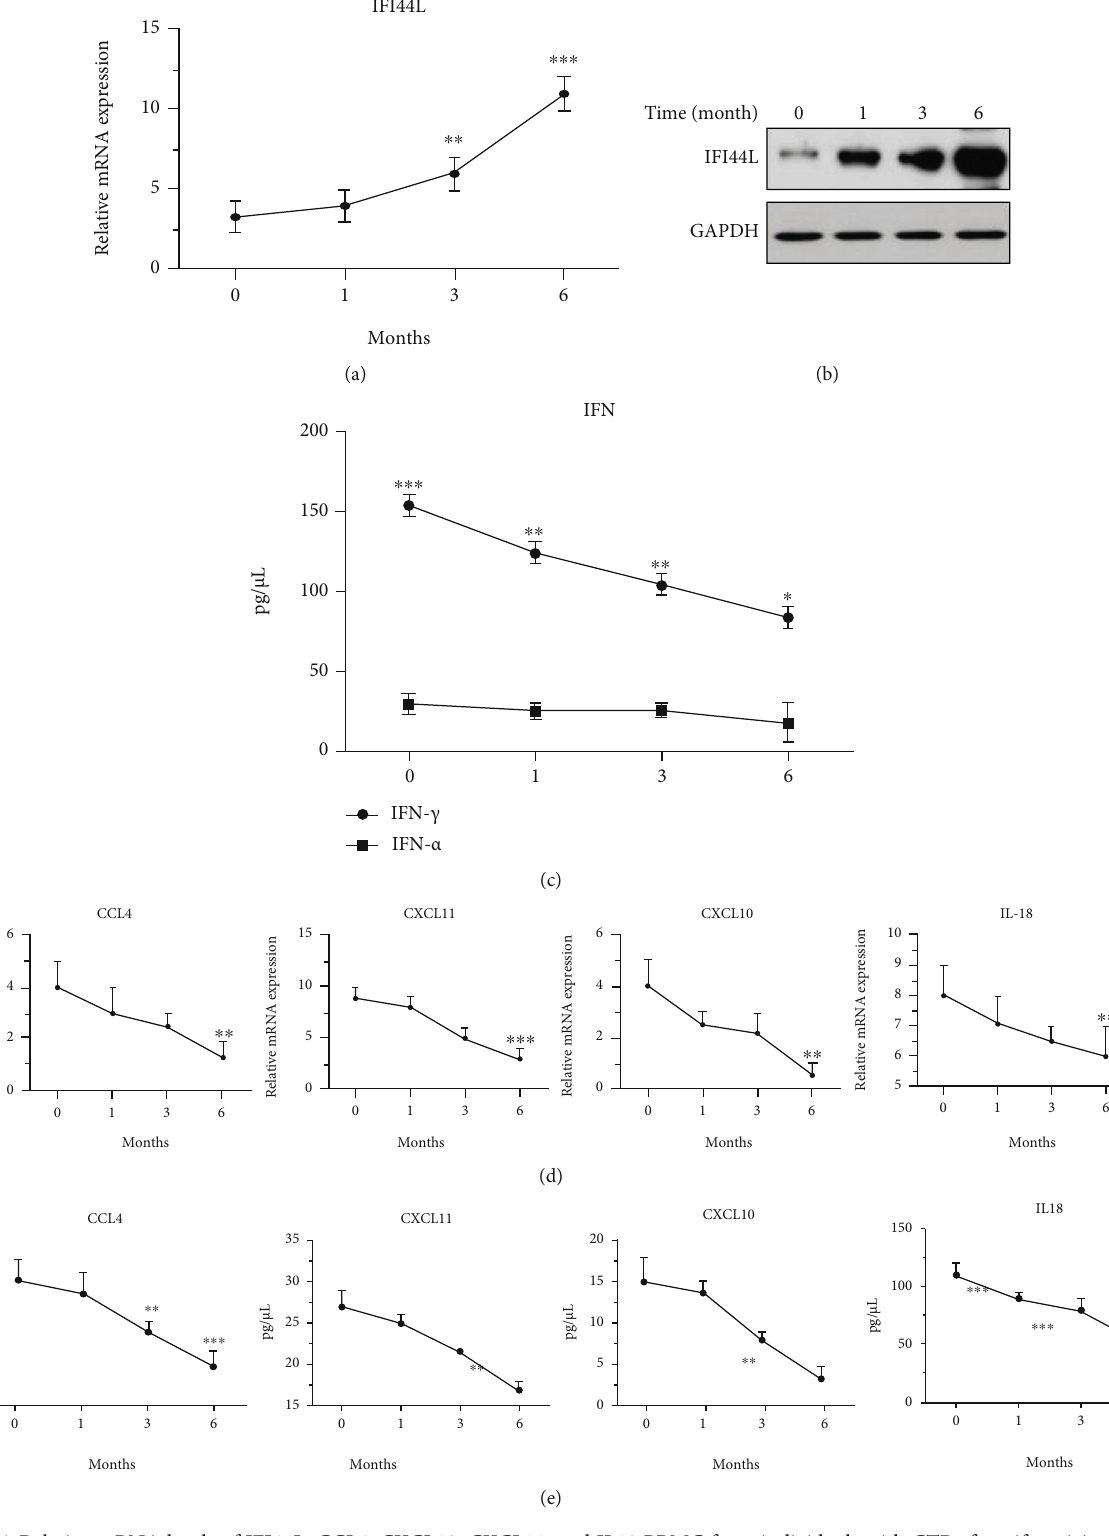
Figure 6: Relative mRNA levels of IFI44L, CCL4, CXCL10, CXCL11, and IL18 PBMC from individuals with CTB after rifampicin as main drug treatment. (a, b) IFI44L expression determined by qPCR and Western blot for 1, 3, and 6 months. (c) IFN- α and IFN- γ expression determined by ELISA. (e, f) CCL4, CXCL10, CXCL11, and IL18 expression determined by qPCR and ELISA. Values are presented as levels relative to β -actin and GAPDH. ∗∗ P < 0 : 01 ; ∗∗∗ P < 0 : 001